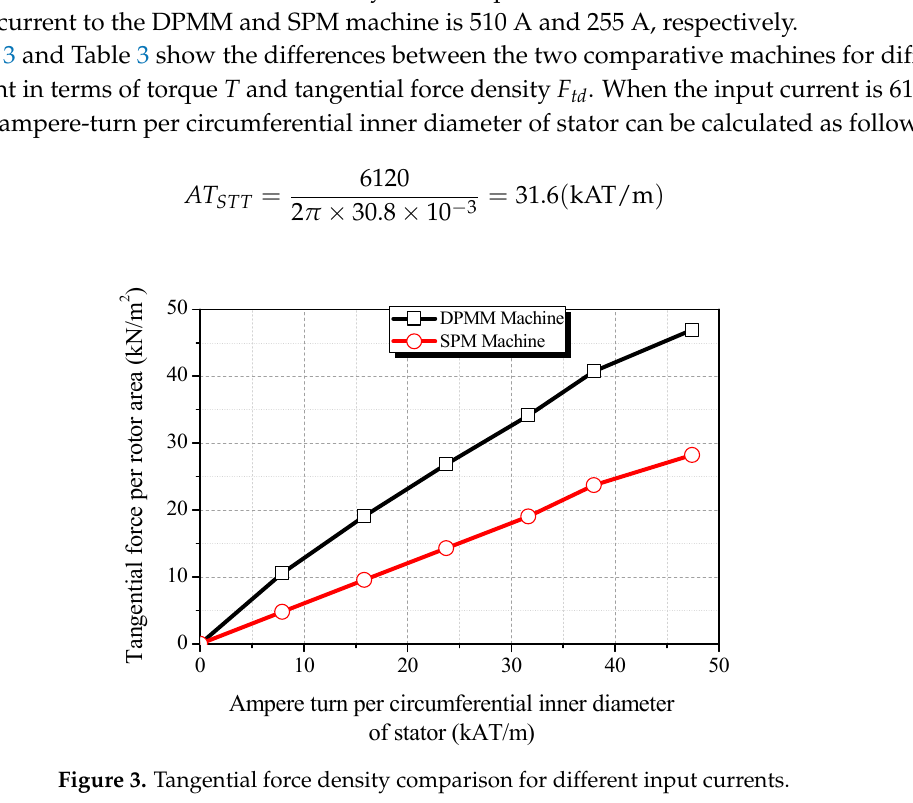
Figure 3. Tangential force density comparison for different input currents.